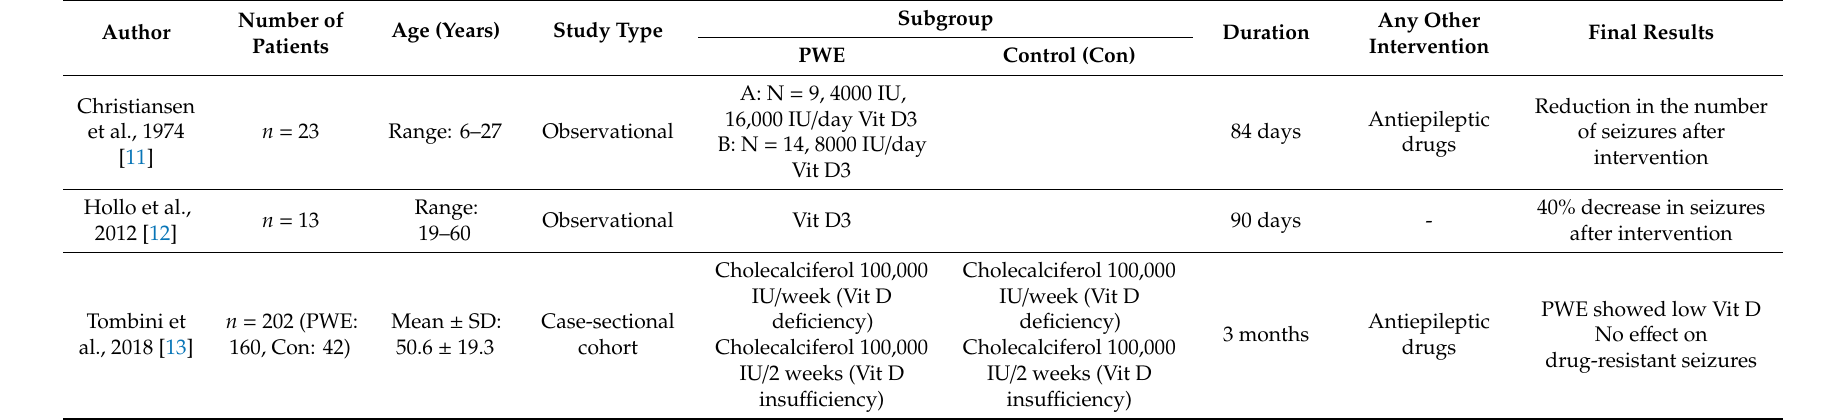
Table 2. Clinical studies assessing the e ffi cacy of vitamin D in patients with